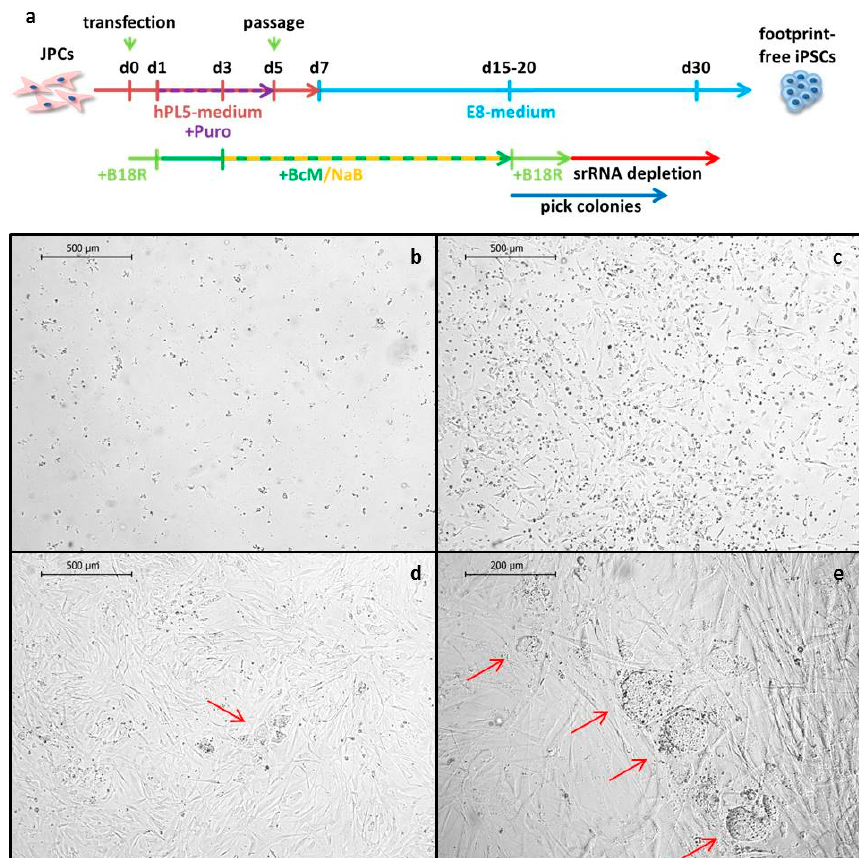
Figure 2. Reprogramming of JPCs. ( a ) Timeline of JPC reprogramming. JPCs were transfected (d0) in hPL5-medium containing 0.2 µg/mL B18R protein. On day one, the medium was changed to hPL5 containing 25% conditioned medium containing B18R (BcM) and 1.0 µg/mL puromycin (Puro). Puromycin selection was continued until day five (purple arrow). Cells were passaged on day five, and on day seven, the medium was changed to Essential 8 (E8) containing 25% BcM. Sodium butyrate (iPSC) colonies emerged, the medium was changed to E8 containing 0.2 µg/mL B18R protein. iPSC srRNA-based reprogramming. ( b ) Untransfected JPCs treated with puromycin at day five. ( c ) srRNA transfected JPCs treated with puromycin at day five. ( d ) srRNA transfected JPCs at day 12 with the first iPSC-colonies (indicated by a red arrow). ( e ) srRNA transfected cells at day 15 with iPSC-colonies